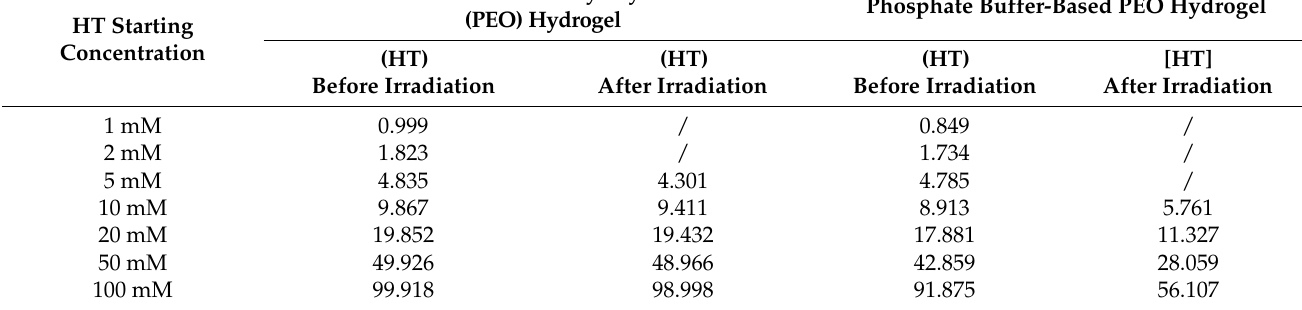
Table 1. High-performance liquid chromatography (HPLC) quantification of residual HT in phosphate and citrated buffer PEO 4% hydrogels after gamma-ray